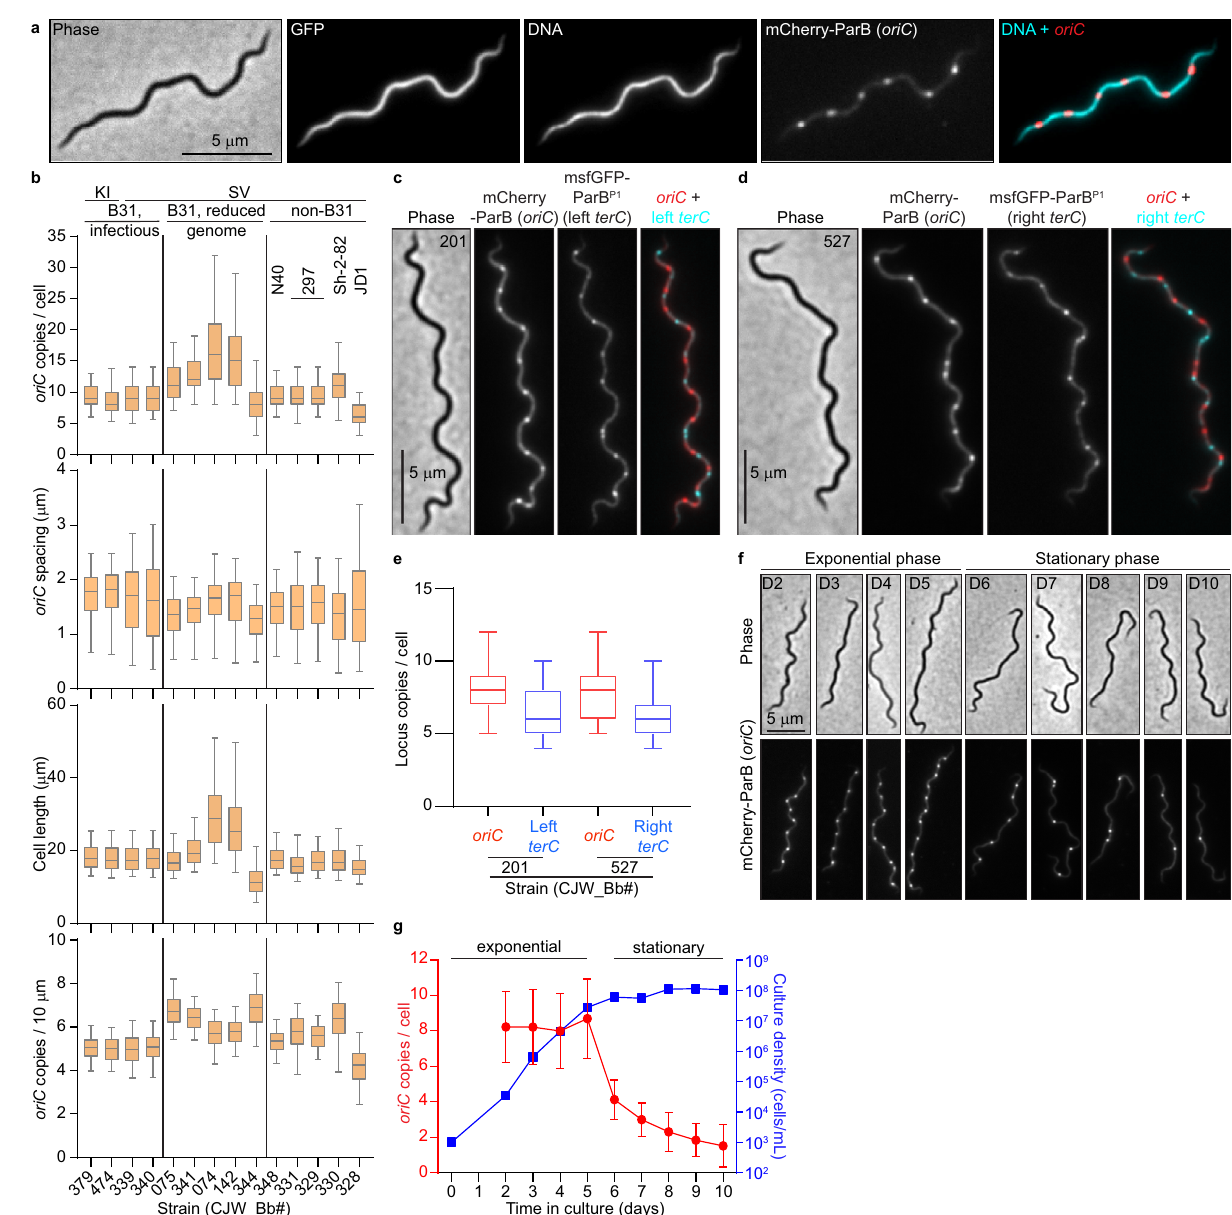
Fig. 1 | B. burgdorferi cells contain multiple chromosome copies. a Images of a cellofstrain CJW_Bb474 expressing cytosolic free GFP and mCherry-ParB.Hoechst 33342 was used to stain the DNA. b Population quanti fi cations of exponentially growing cultures of the strains shown in Supplementary Fig. 1c. Top to bottom: copy numbers per cell of the labeled oriC loci; oriC spacing (distances between adjacent oriC spots); cell lengths; and oriC densities (copies per 10 μ m of cell length). Strain numbers are indicated at the bottom. Shown are the mean of the data (middle line), the 25 to 75 percentiles of the data (box), and the 2.5 to 97.5 percentiles of the data (whiskers). Strain backgrounds and oriC labeling method ( mcherry-parB knock-in,KI,ortagged parB expressedfromashuttlevector,SV)are listed at the top. c Phase-contrast and fl uorescence micrographs of a cell of strain CJW_Bb201, which expresses labels for oriC (mCherry-ParB) and the left terC locus (msfGFP-ParB P1 ), respectively. d Phase-contrast and fl uorescence micrographs of a cell of strain CJW_Bb527, which expresses labels for oriC (mCherry-ParB) and the